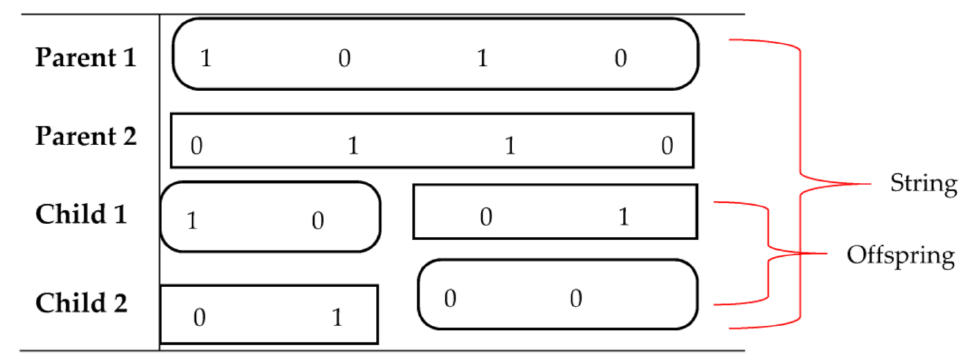
Figure 4. Exchanging genes among parents to form